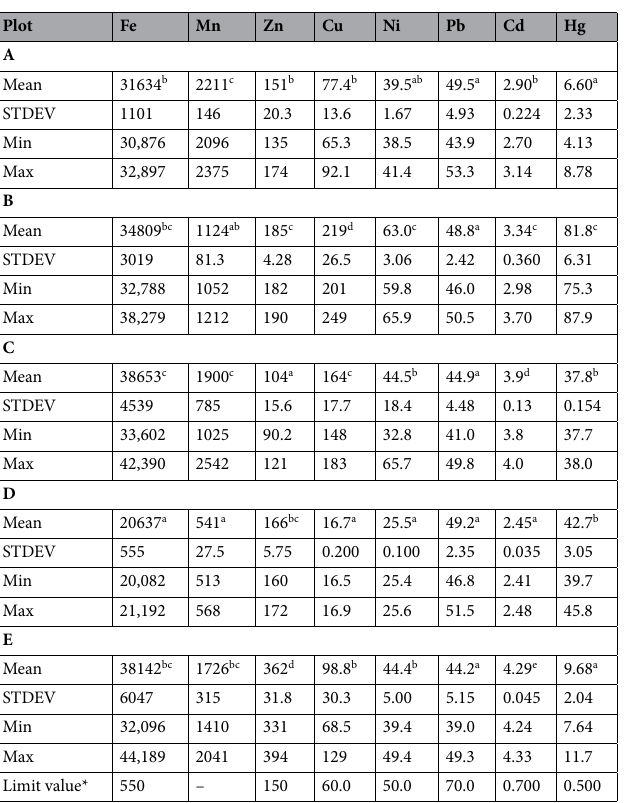
Table 1. The content of pseudototal forms of heavy metals in the soil (mg/kg). *For soil extract by aqua regia according to legislation valid in the Slovak Republic 31 . a–d Statistically significant differences between plots, P value < 0.0 of One-Way ANOVA